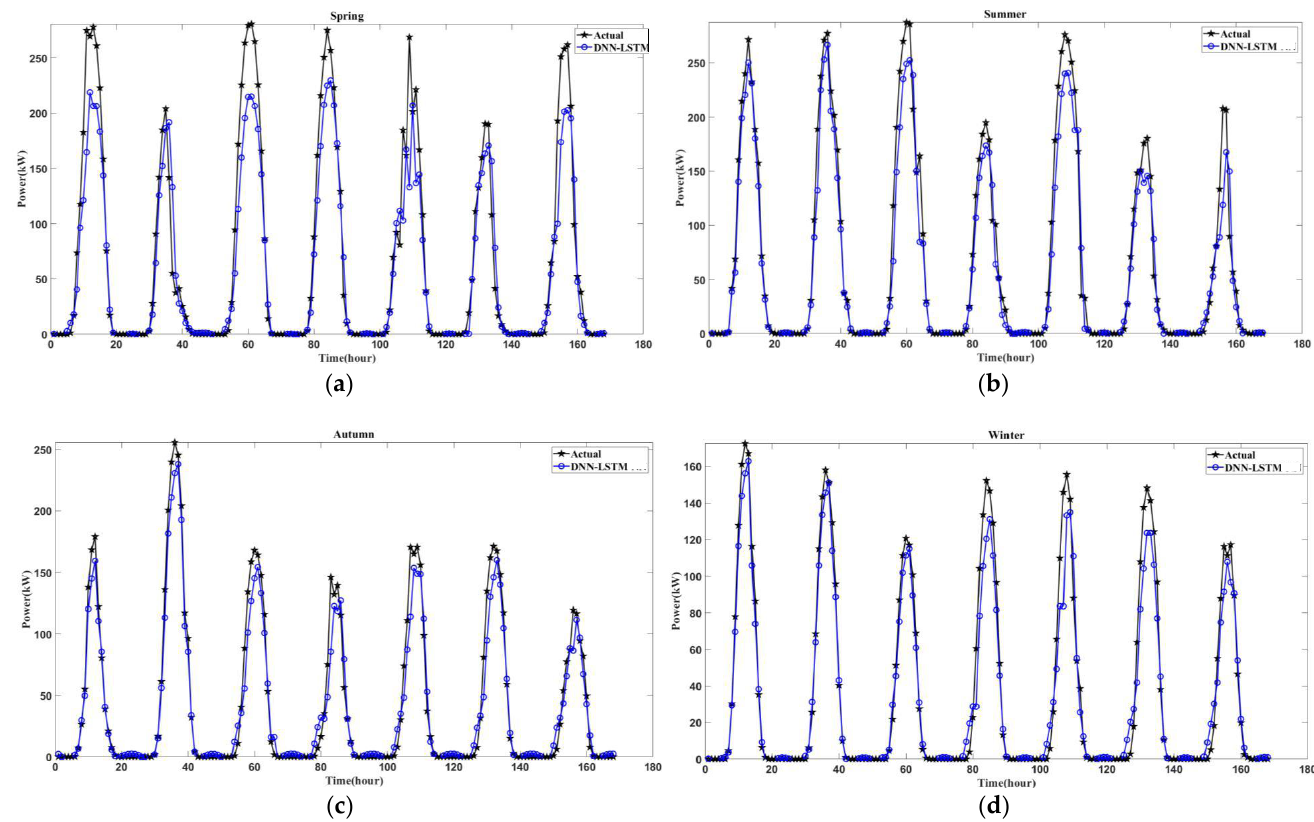
Figure 10. Hourly power generation forecasting results by DNN- LSTM during one week for solar power plant E: ( a ) spring; ( b ) summer; ( c ) autumn; ( d ) winter. Table 9. Comparisons of performance indicators of five forecasting models for solar power plant E.